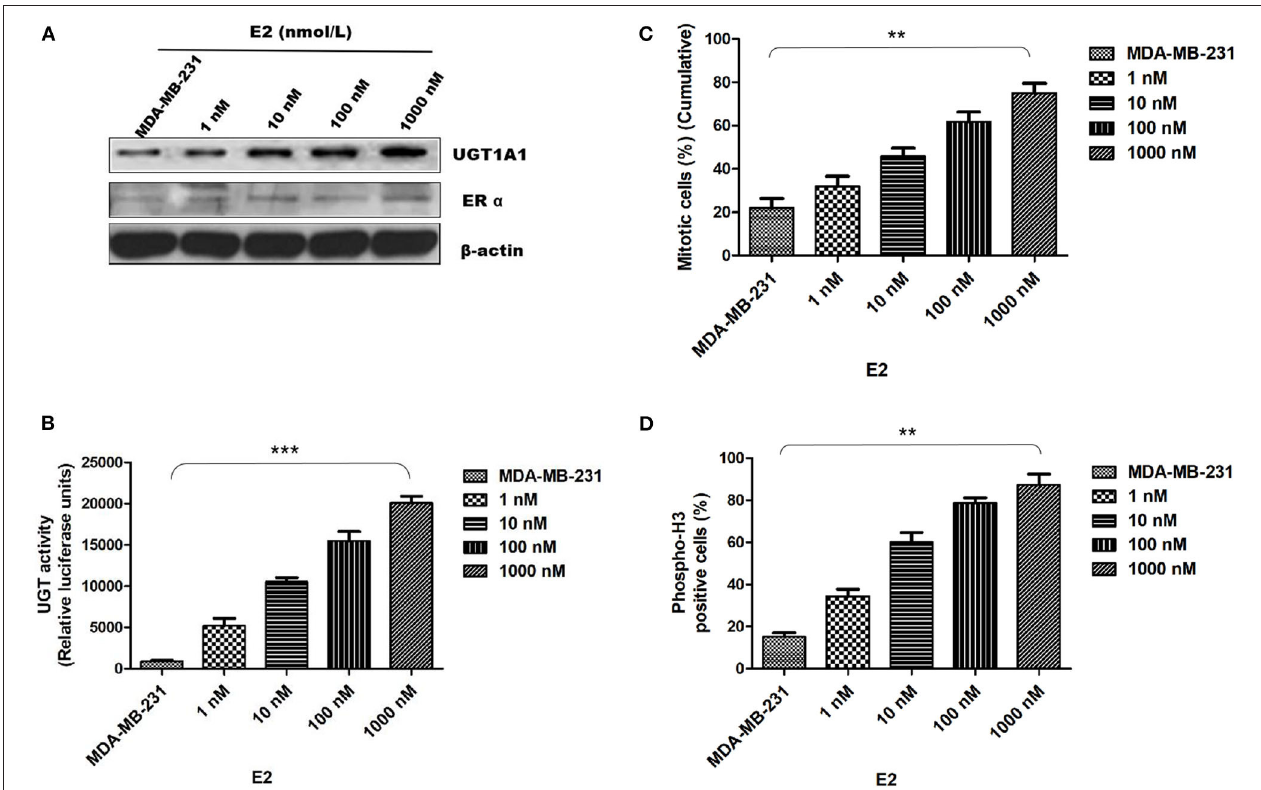
FIGURE 4 | Estrogen upregulated the expression of UGT1A1 and its enzyme activity in TNBC cell line MDA-MB-231, and promoted cell proliferation. In this experiment, the cell line MDA-MB-231 was treated with 17 β -estradiol (E2) in the presence of concentration gradients. Our results demonstrated that the 17 β -estradiol (E2) could strongly promote the expression of UGT1A1 in a dose-dependent manner, but lightly upregulate the ER α expression (A) . Moreover, the enzyme activity of UGT1A1 was determined, and these results indicated the presence of concentration gradients, too. Our results demonstrated that the E2 induced forcefully the UGT1A1 activity in a dose-dependent manner (B) . Furthermore, the cell mitosis was released after using the block with double thymidine to synchronize cell at the G1/S phase, then the synthesis of DNA was evaluated with BrdU. Incorporating BrdU into the control, the mitotic cells treated with E2 increased obviously than control in a dose-dependent manner (C) . Our results indicated that the expression and enzyme activity of UGT1A1 upregulated by E2 may control the DNA synthesis, and then transition of G1/S boundary or mitosis in TNBC cells. The flow cytometry and stain of phospho-H3 was additionally used to confirm the role of UGT1A1 expression and enzyme activity in mitotic entry of TNBC cells (D) . Estrogen 17 β -estradiol (E2) significantly promoted mitotic entry of TNBC cells. In summary, these results sustained powerfully the estrogen as a positive factor in the proliferation of TNBC cells at onset of mitosis through accentuating the expression and enzyme activity of UGT1A1. ** P < 0.01, *** P <